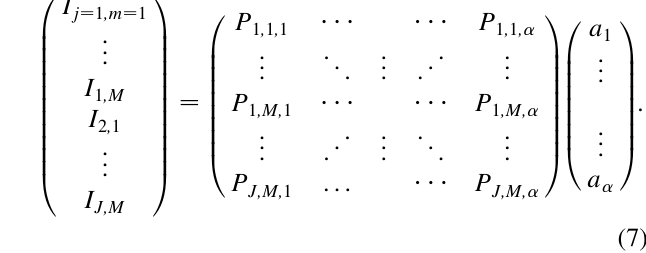
FIG. 1. (Color) Dual-sweep streak-camera image of giant pulse. The camera recorded the time structure of the intensity of the light generated by the E beam on multiple turns. The fast vertical sweep, which is synchronized with the revolution of the E beam, has the full scale of 1.6 nsec. The slow horizontal sweep has the full scale of 500 msec. The trace seen at top is the FEL light. The main image is that of the spontaneous radiation of electron beam, which is identical to the beam time